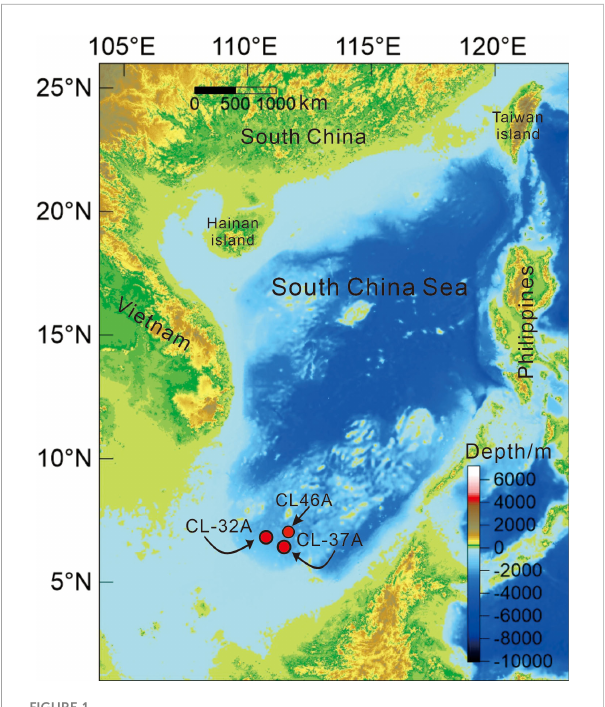
FIGURE 1 Map of the regional tectonic and sampling site locations in the Beikang